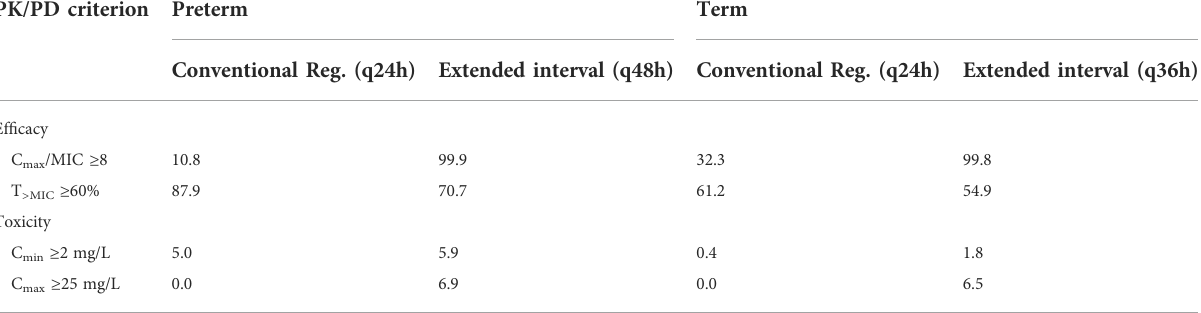
TABLE 5 Probability of target attainment (PTA) for ef fi cacy and toxicity criteria (%) (MIC = 1 mg/L). PK/PD criterion Preterm